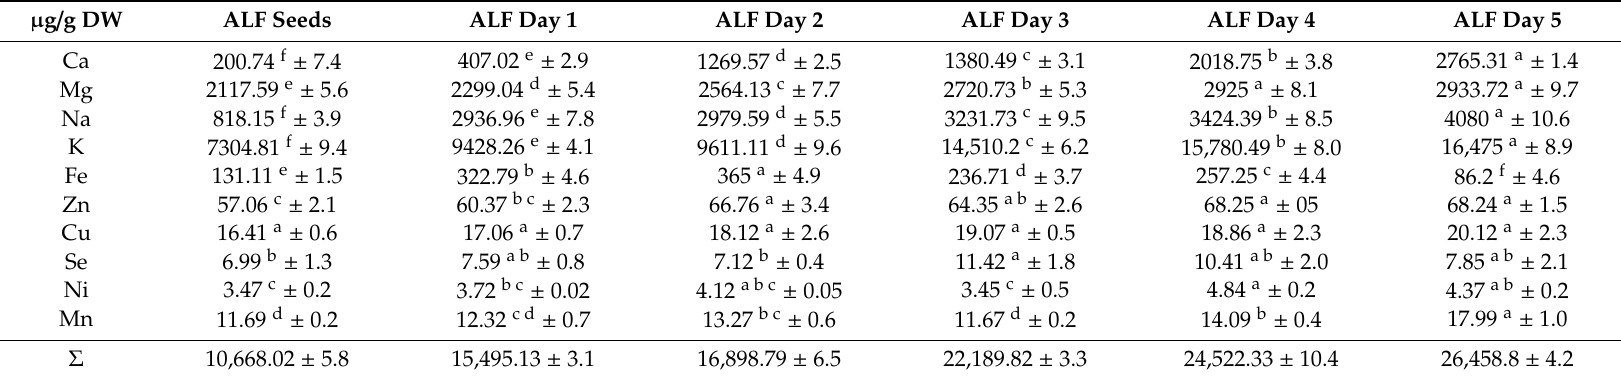
Table 1. Minerals in ALF sprouts in µ g / g DW (dried weight) of vegetal material (ALF sprouts samples were coded as: day 1—first day of germination; day 2—second